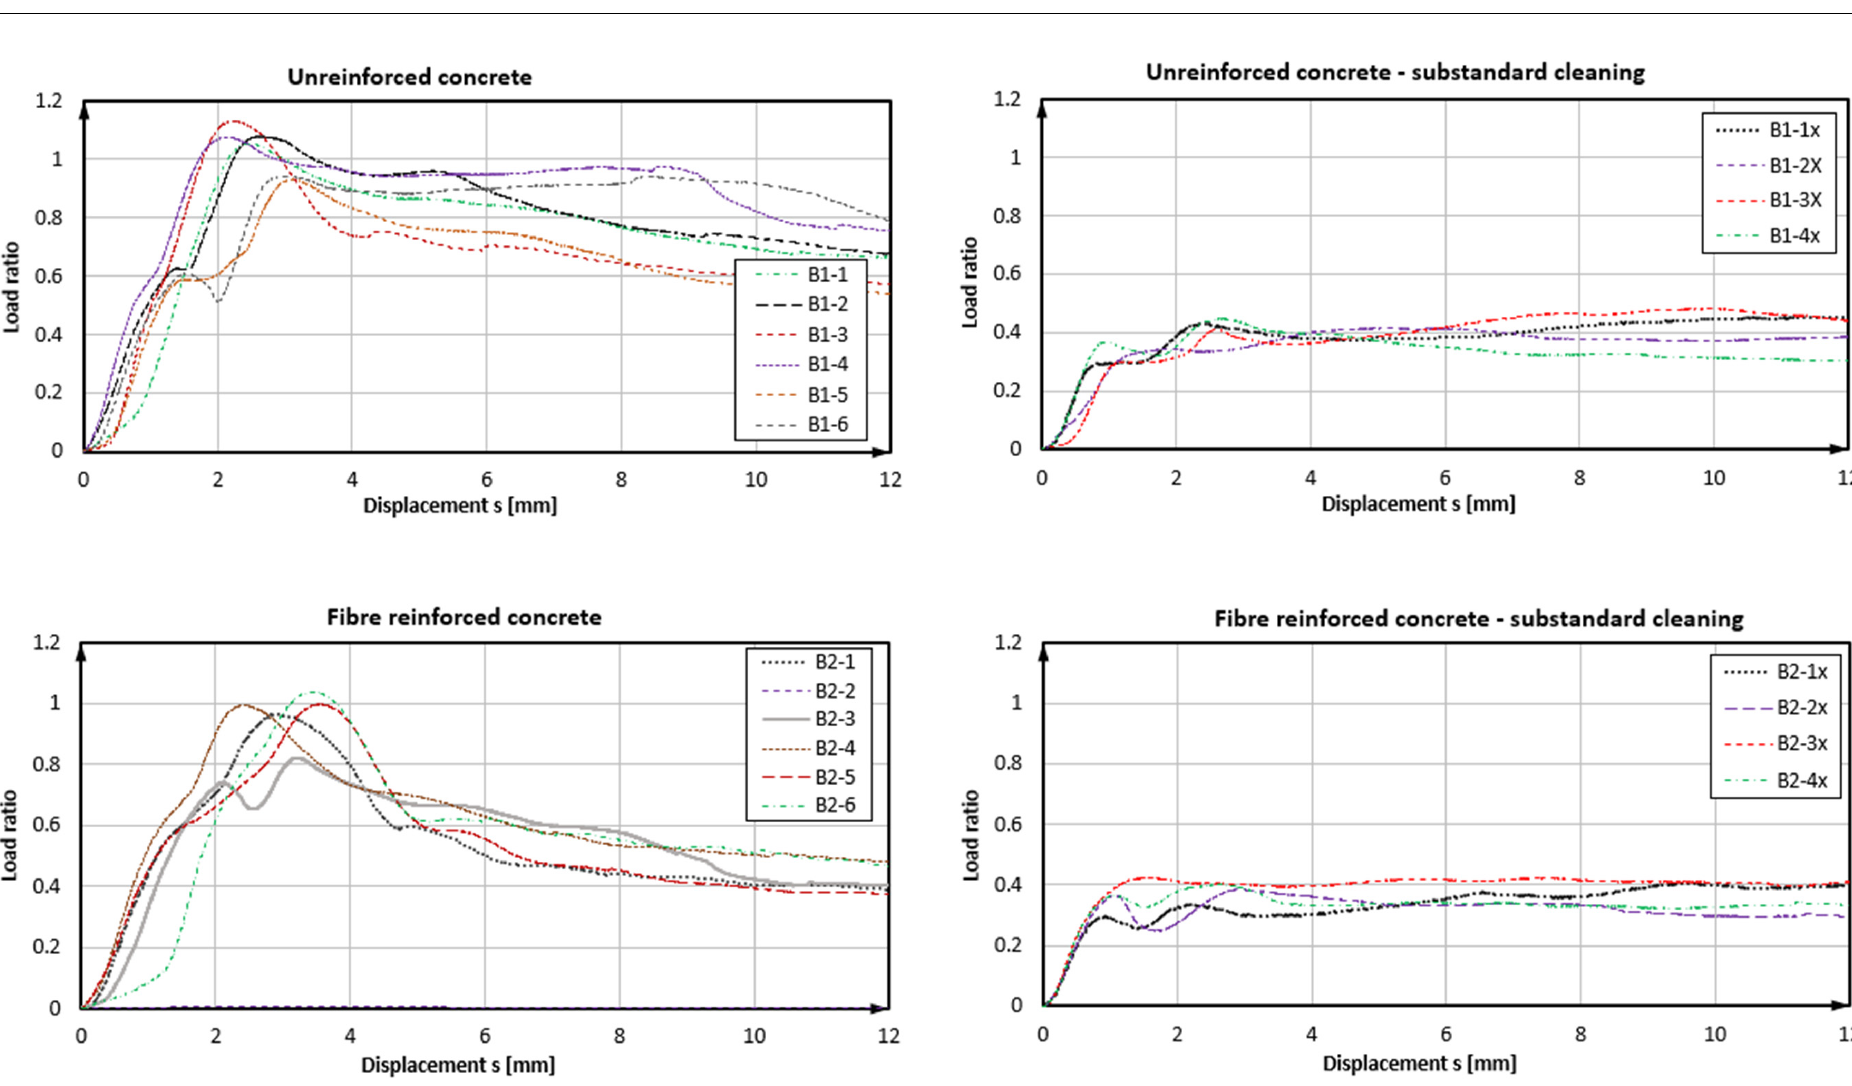
Figure 7. Load displacement curves of confined pull-out tests—Product B.